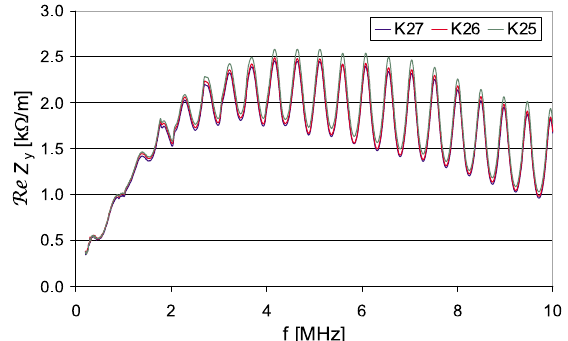
FIG. 29. (Color) Vertical impedance of production kicker sys- tems K25, K26,